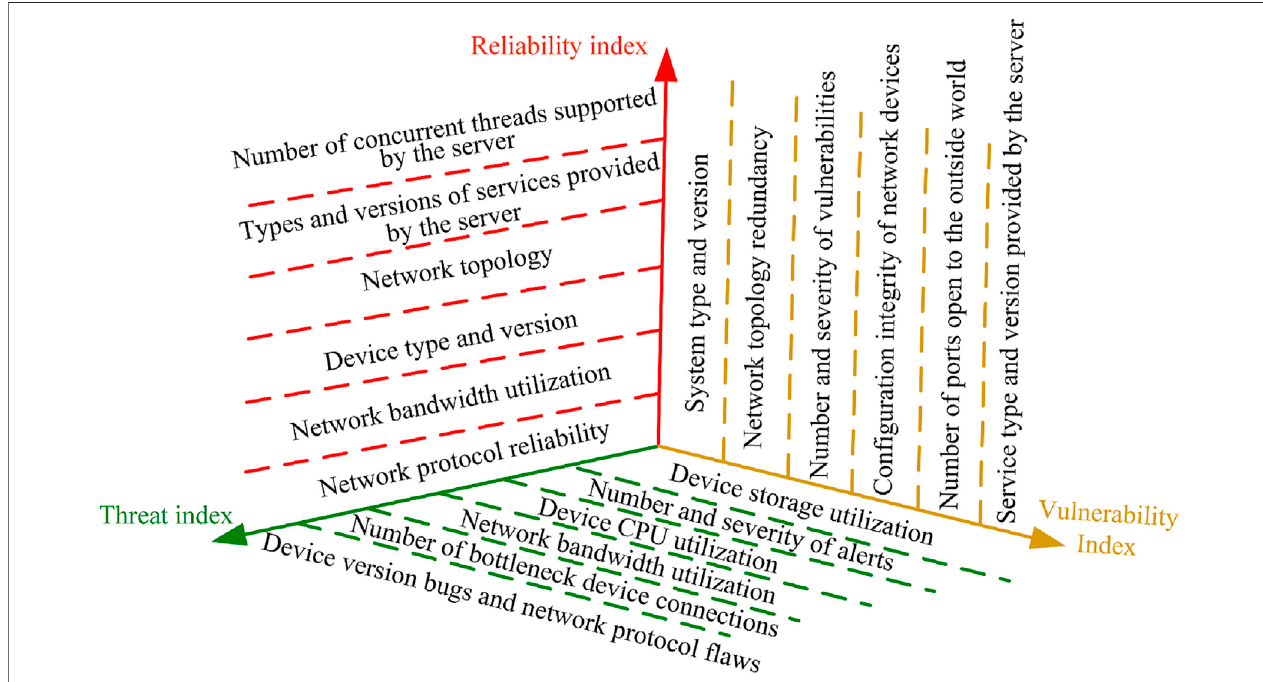
FIGURE 1 | Spatial index system of network security situation